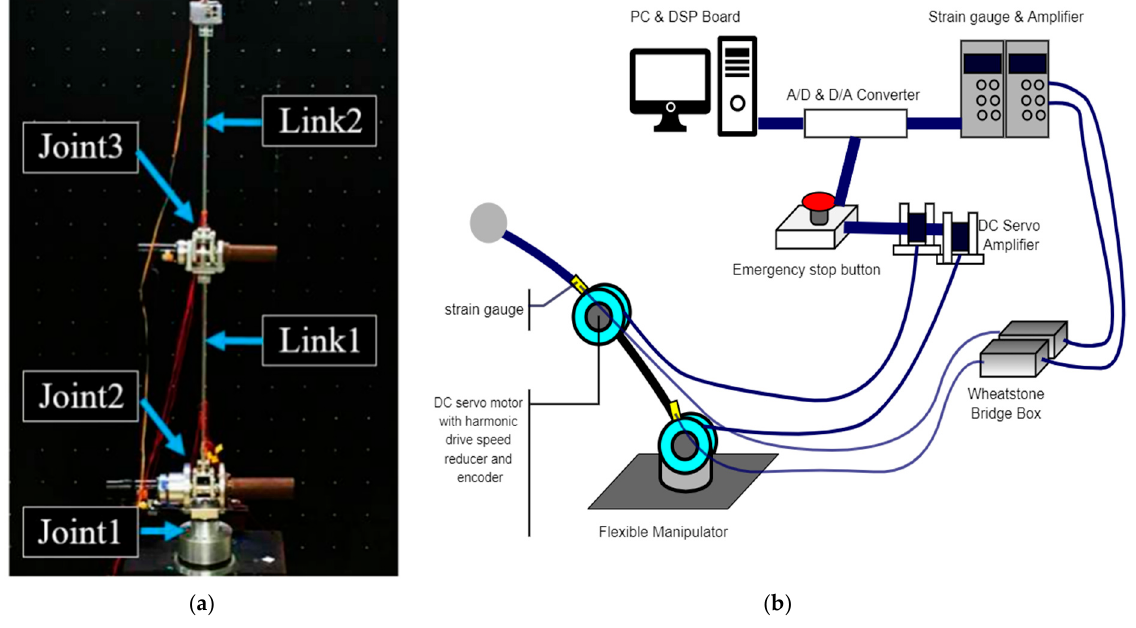
Figure 1. Setup of the flexible manipulator. ( a ) Actual flexible manipulator. ( b ) Illustration of the manipulator setup.